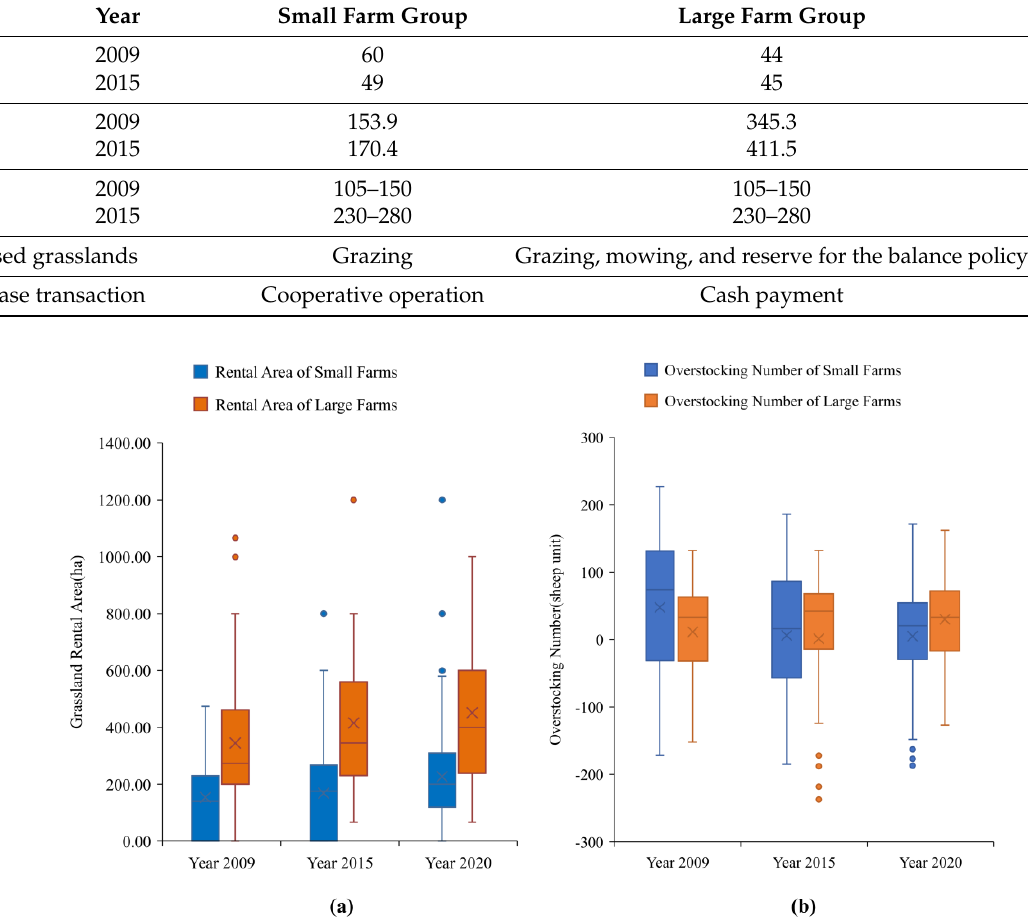
Figure 1. Box plots of grassland rental areas of large and small farms in 2009, 2015 and 2020 ( a ), and overgrazing numbers for large and small farms in 2009, 2015 and 2020 ( b ).